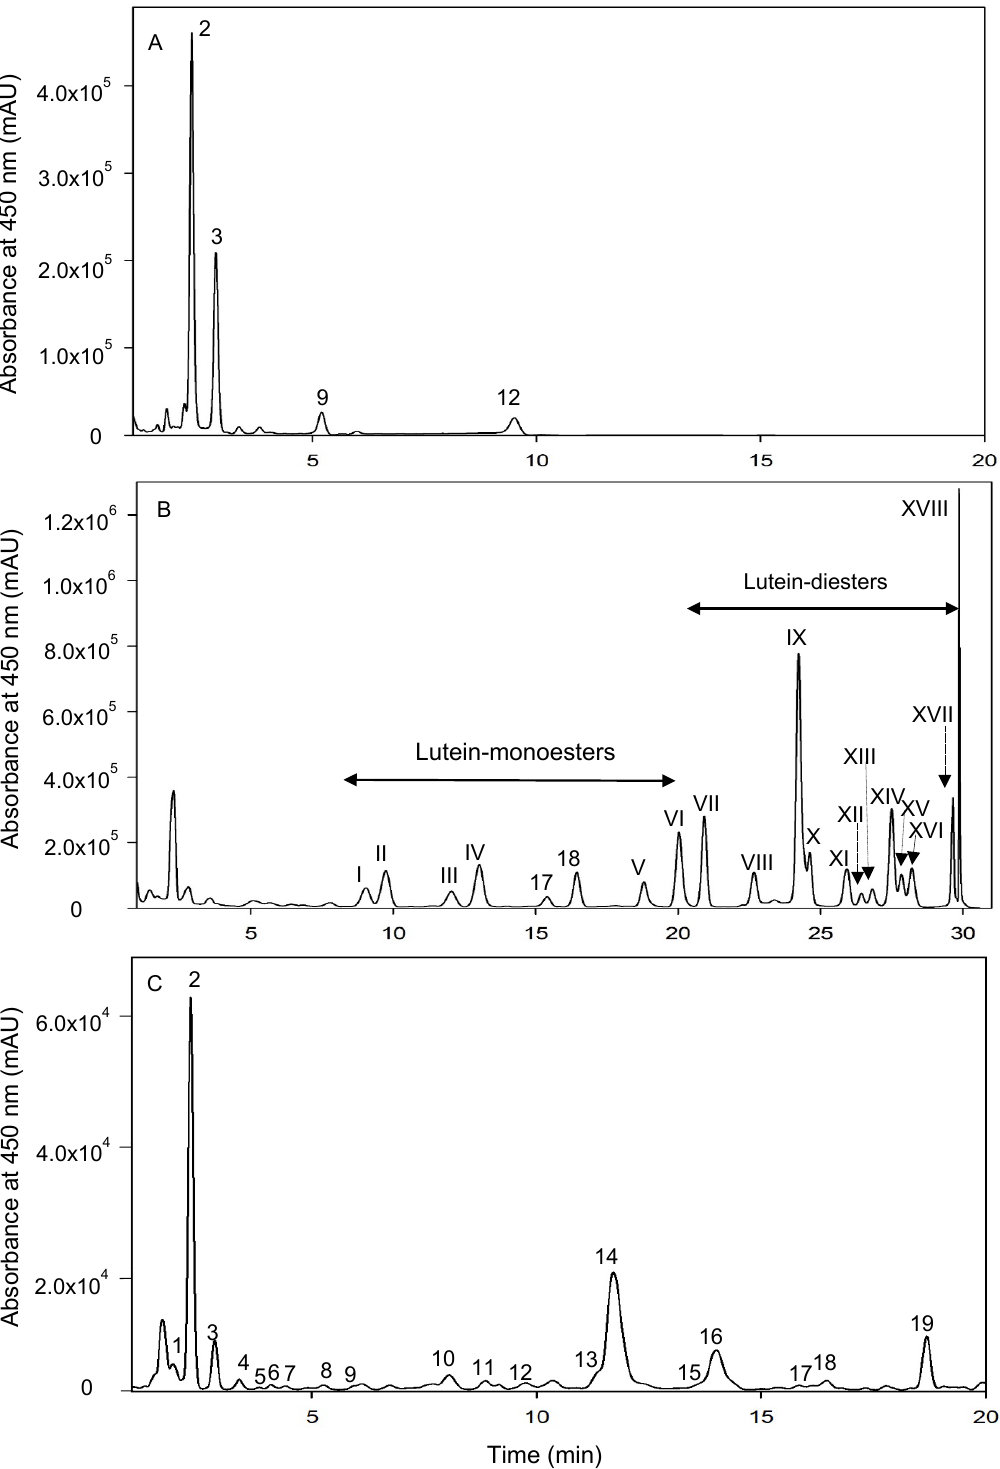
Figure 1. UPLC chromatograms of authentic carotenoid standards ( A ), lab-prepared mono- and di-esters of lutein standards ( B ) and canary seed extract ( C ). Numbers 1–19 correspond to